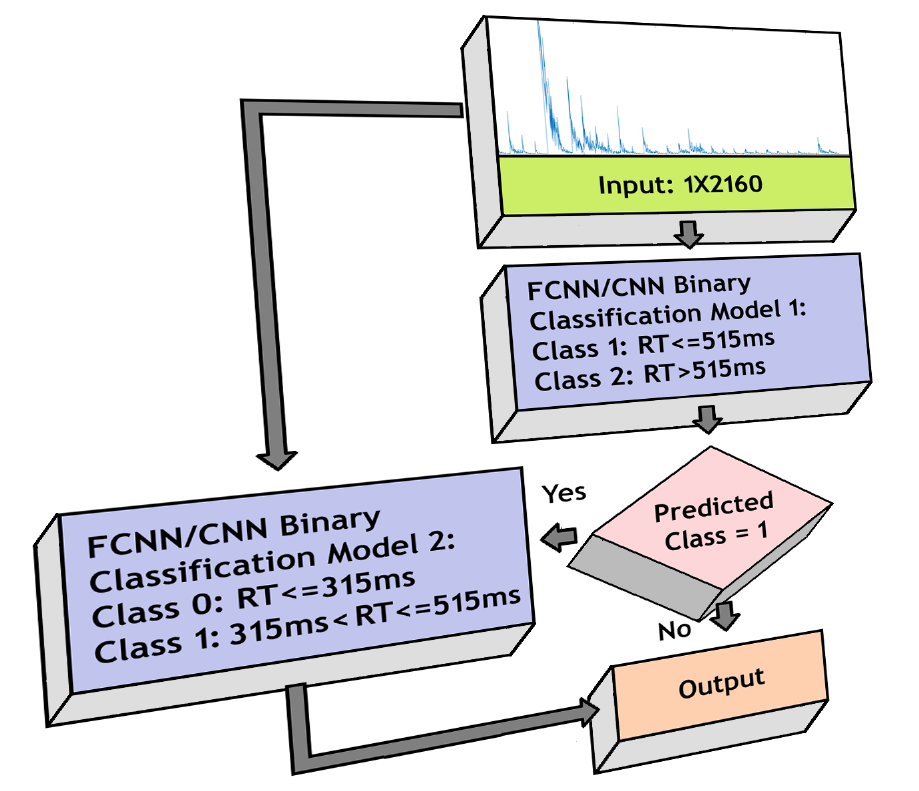
Figure 6. Model for 3-class classification using FCNN/CNN